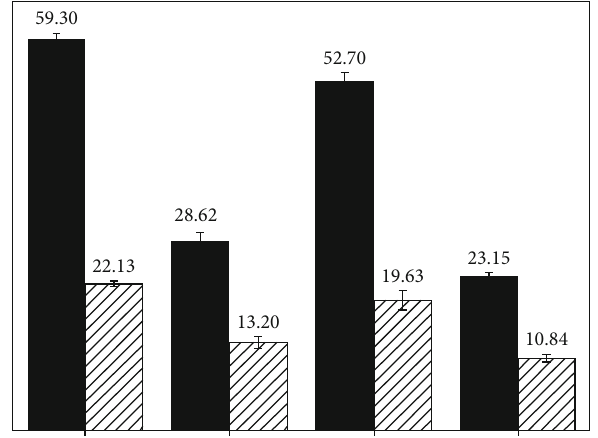
Figure 6: Comparison of the phosphate removal of the two synthesized UiO-66 samples, adsorbed and electrosorbed in the 30 mg/L sodium dihydrogen phosphate